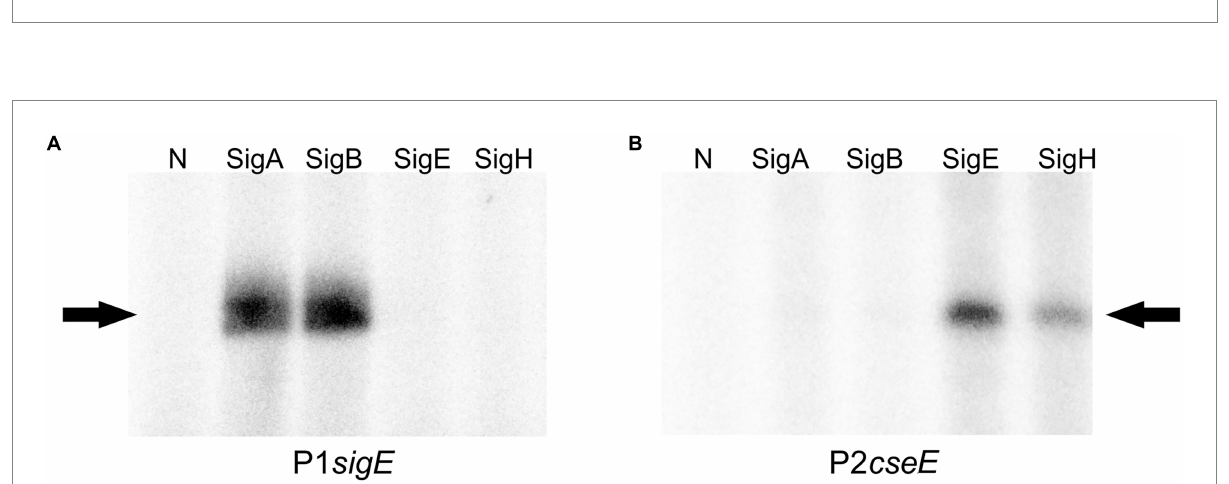
FIGURE 4 In vitro transcription with P1 sigE (A) and P2 cseE ( B ; the key promoters of the operon) used as templates. Individual sigma factors associated with the C. glutamicum RNAP core are shown at the top. N; no sigma factor protein was added to the RNAP core. The specific transcripts are indicated with arrows.